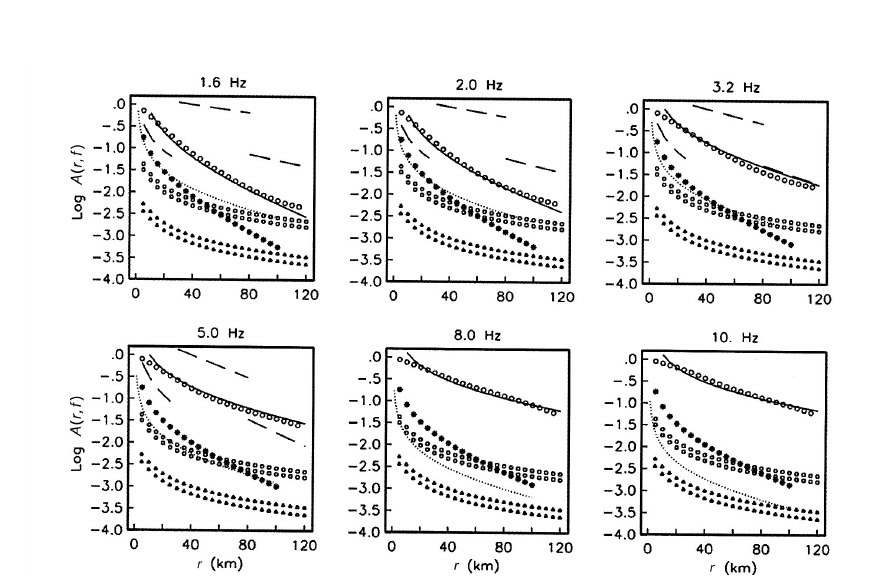
Fig. 9. Parametric Attenuation Functions (PAF) reported in different regions of Italy. The nonparametric functions obtained in this study are plotted with open circles. The solid lines are the attenuation functions calculated with eq. (4.1) using the values listed in table III. The dashed lines are the PAF calculated with the Q and G ( r ) obtained by Malagnini et al. (2000) (see table III). The dotted curves are the PAF reported by Rovelli et al. (1988) (eq. (4.4)).The asterisks are the PAF of Castro et al. (2003b). The squares and the tri- angles are the PGA and PGV attenuation functions, respectively, of Sabetta and Pugliese (1987) (eqs. (4.5) and (4.6)).